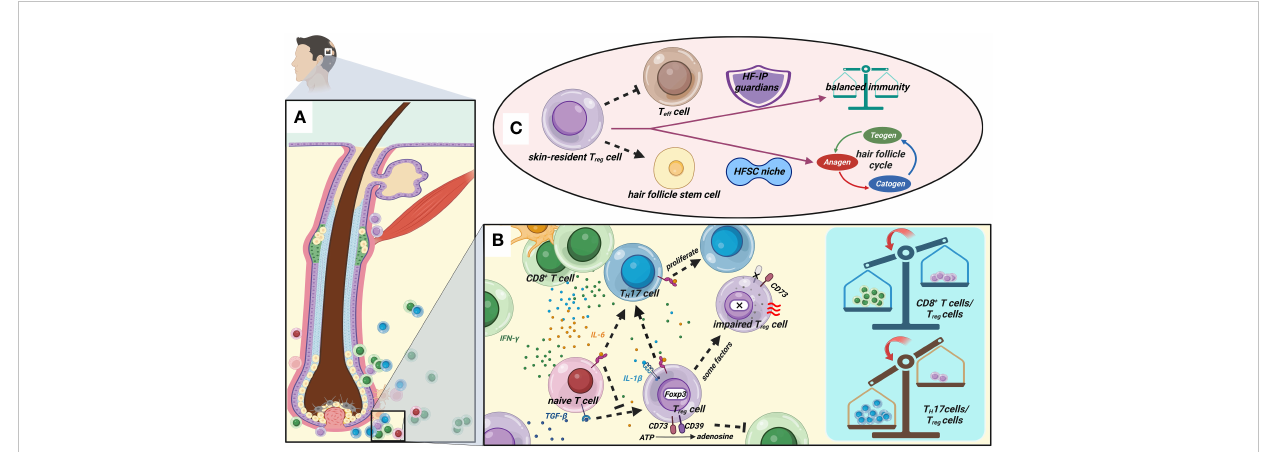
FIGURE 1 Great importance of T reg cells in AA. (A) The anagen HF of AA patients. (B) There are tremendous amounts cytokines in the HF after immune attack. IL-6 inhibits the generation of Foxp3 + T reg cells induced by TGF- b and induces the differentiation of pathogenic T H 17 cells. IL-6 and IL-1 b could reverse T reg cells ’ suppressive function or result in their conversion to T H 17 cells. Some issues lead to intrinsic defects of T reg cells such as loss of expression of CD39 and Foxp3. Eventually, impairment of T reg cells contributes to the imbalance of immunocyte populations including CD8 + T cells/ T reg cells and T H 17 cells/T reg cells. (C) Skin-resident T reg cells have dual roles in maintaining immune homeostasis as HF-IP guardians and localizing in the HFSC niche to drive the cyclic growth of HF. (Figure1 created with